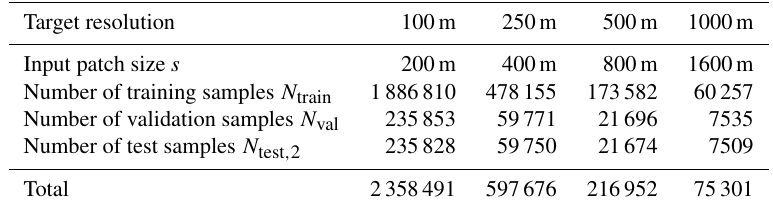
Table 1. Input sample patch size and number of samples under different target